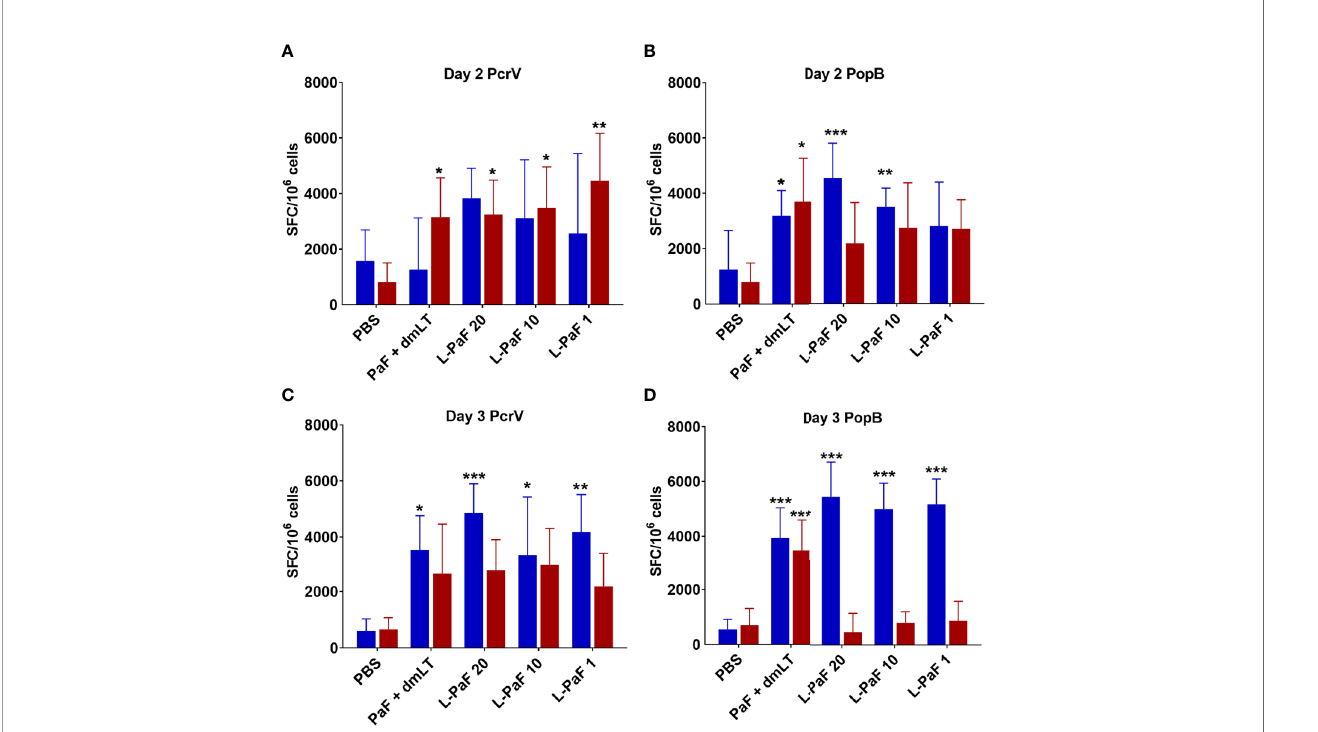
FIGURE 11 | Frequency of IL-17 and IFN- g secreting cells from mice after antigen-speci fi c stimulation. Mice (n=10) vaccinated with PBS, PaF (20 µg) admixed with dmLT (2.5 µg) or with 20, 10 or 1 µg of L-PaF on days 0, 14, 28. The single lung cell suspensions were obtained and used to assess antigen speci fi c IL-17 and IFN- g secreting cells. Cells were incubated with 10 µg PcrV (top) or PopB (bottom). IL-17 (blue bars) and IFN- g (red bars) secreting cells were enumerated by ELISpot and are presented here as spot forming cells/10 6 cells. The data are plotted as means ± SD for individual mice in each group. Signi fi cance was calculated by comparing groups that were unvaccinated (PBS) and mice vaccinated with antigens using two-way ANOVA. *p < 0.05; **p < 0.01; ***p <